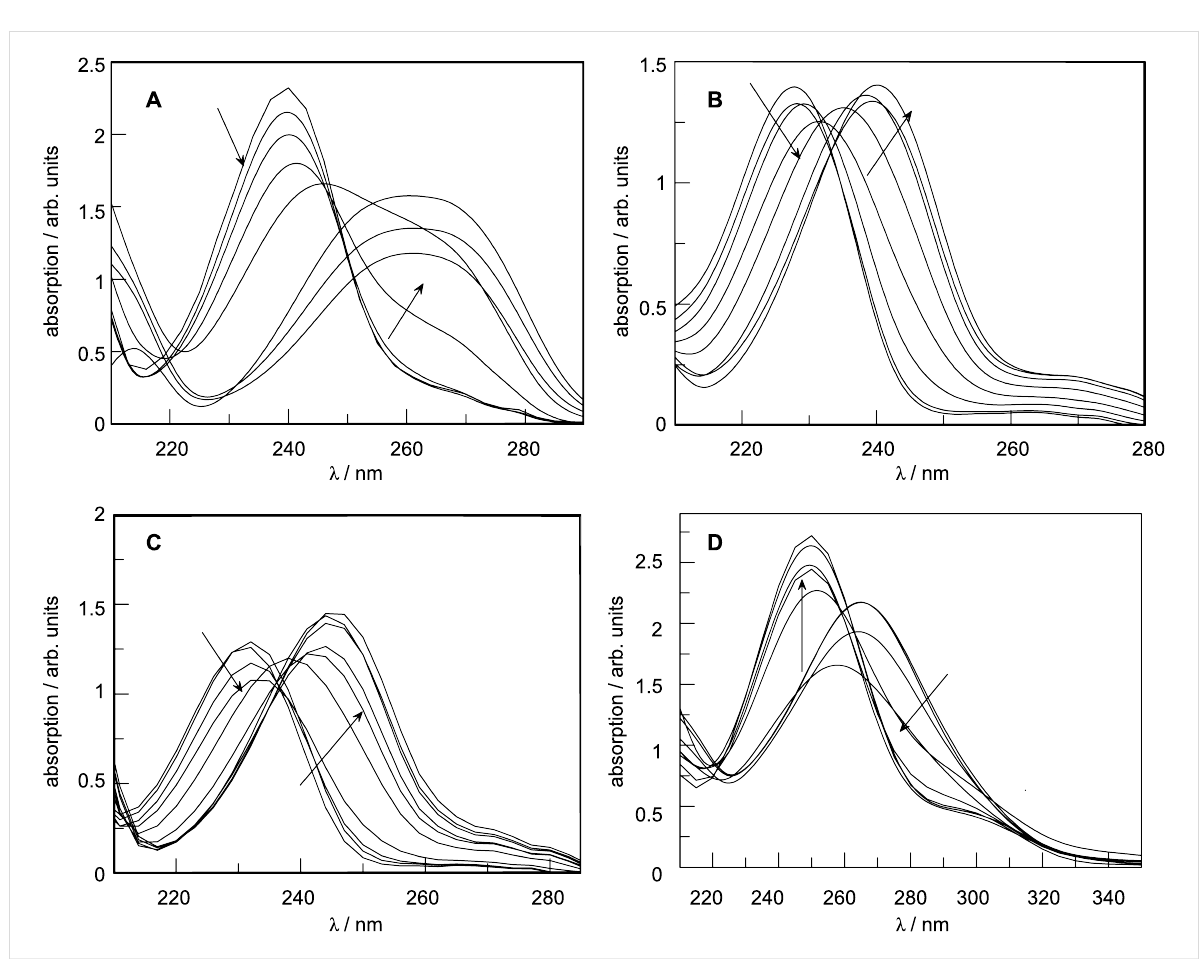
Figure 1: Absorption spectra at 25 °C of 5 × 10 − 5 M aqueous sulfuric acid solutions of: (A) 3a , (B) 3b , (C) 3c , and (D) 3d . Acid concentration varies between 0 and 97%